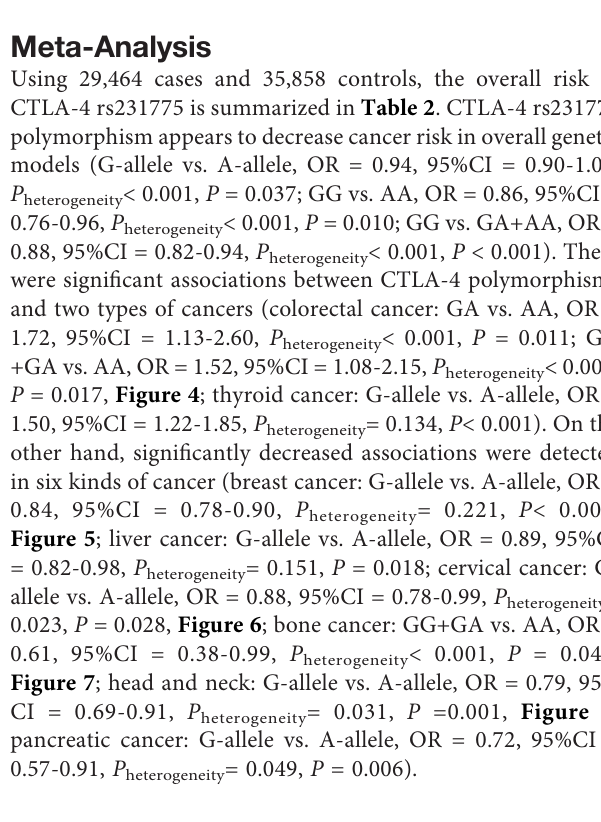
survival rate in patients with head and neck squamous cell